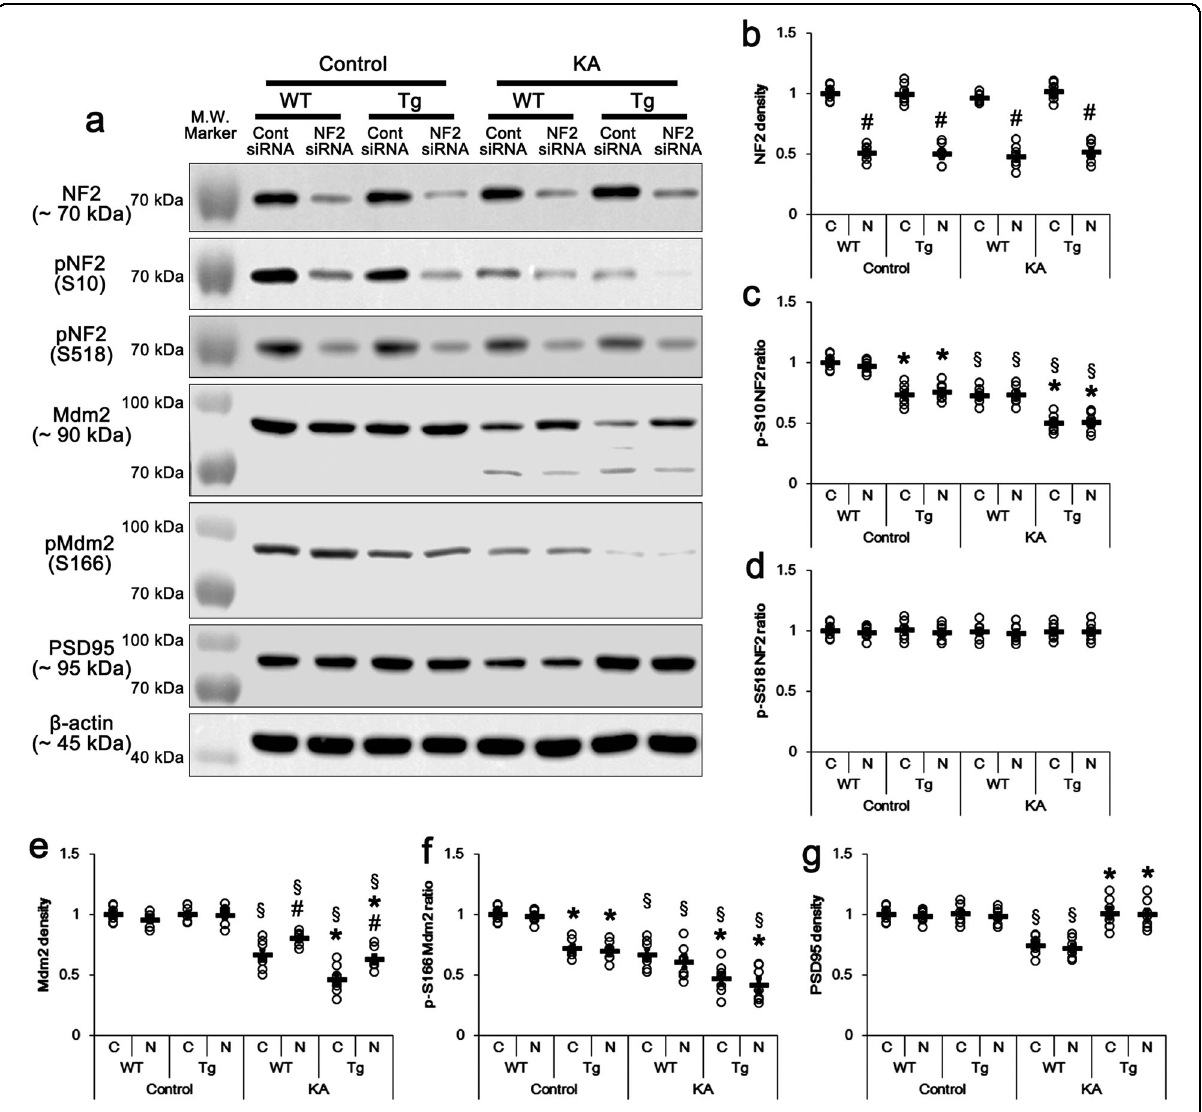
Fig. 6 Effects of NF2 knockdown on protein and phosphorylation levels of NF2, Mdm2, and PSD95 in PLPP/CIN Tg mice following KA injection. a Representative western blots of NF2, pNF2-S10, pNF2-S518, Mdm2, pMdm2-S166, and PSD95. b – g Quanti fi cation of NF2, pNF2-S10, pNF2-S518, Mdm2, pMdm2-S166, and PSD95 levels based on western blot data. Open circles indicate each individual value. Horizontal bars indicate mean value (* ,#,$ p < 0.05 vs. WT, control siRNA- and control (non-KA-treated) animals, respectively; n =